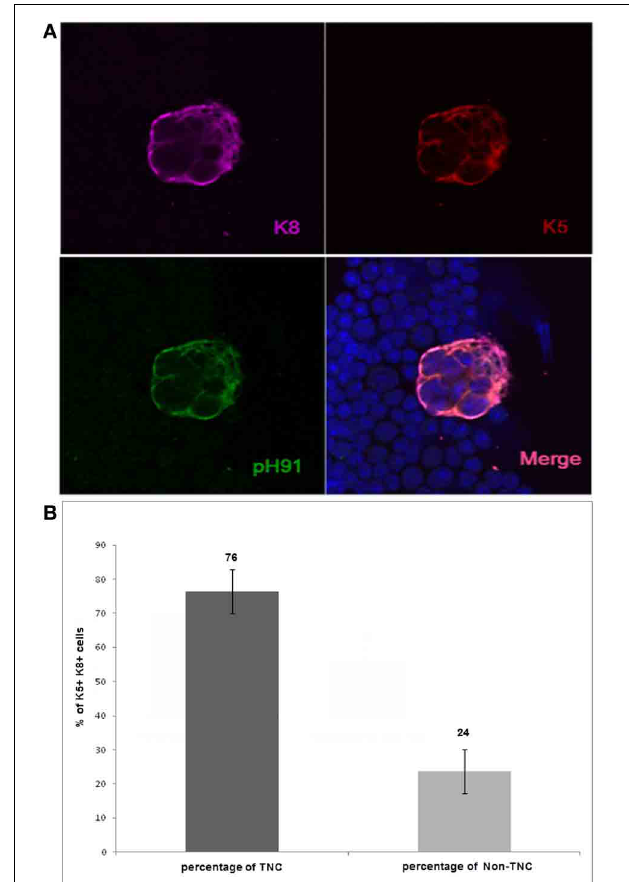
FIGURE 1 | Confocal analysis of K5 + K8 + pH91 + ex vivo multicellular TNCs. (A) shows isolated TNCs stained with anti-K8 antibody (magenta); anti-K5 antibody (red); and the TNC-specific antibody pH91 (green). (A) (lower right) shows a merged image. Original magnification 40 × . (B) shows the quantification of the K5 + K8 + pH91 + TNCs as well as K5 + K8 + non-TNCs. Isolated K5 + K8 + cells were manually counted (1000) using a Zeiss confocal microscope. Data represent three independent